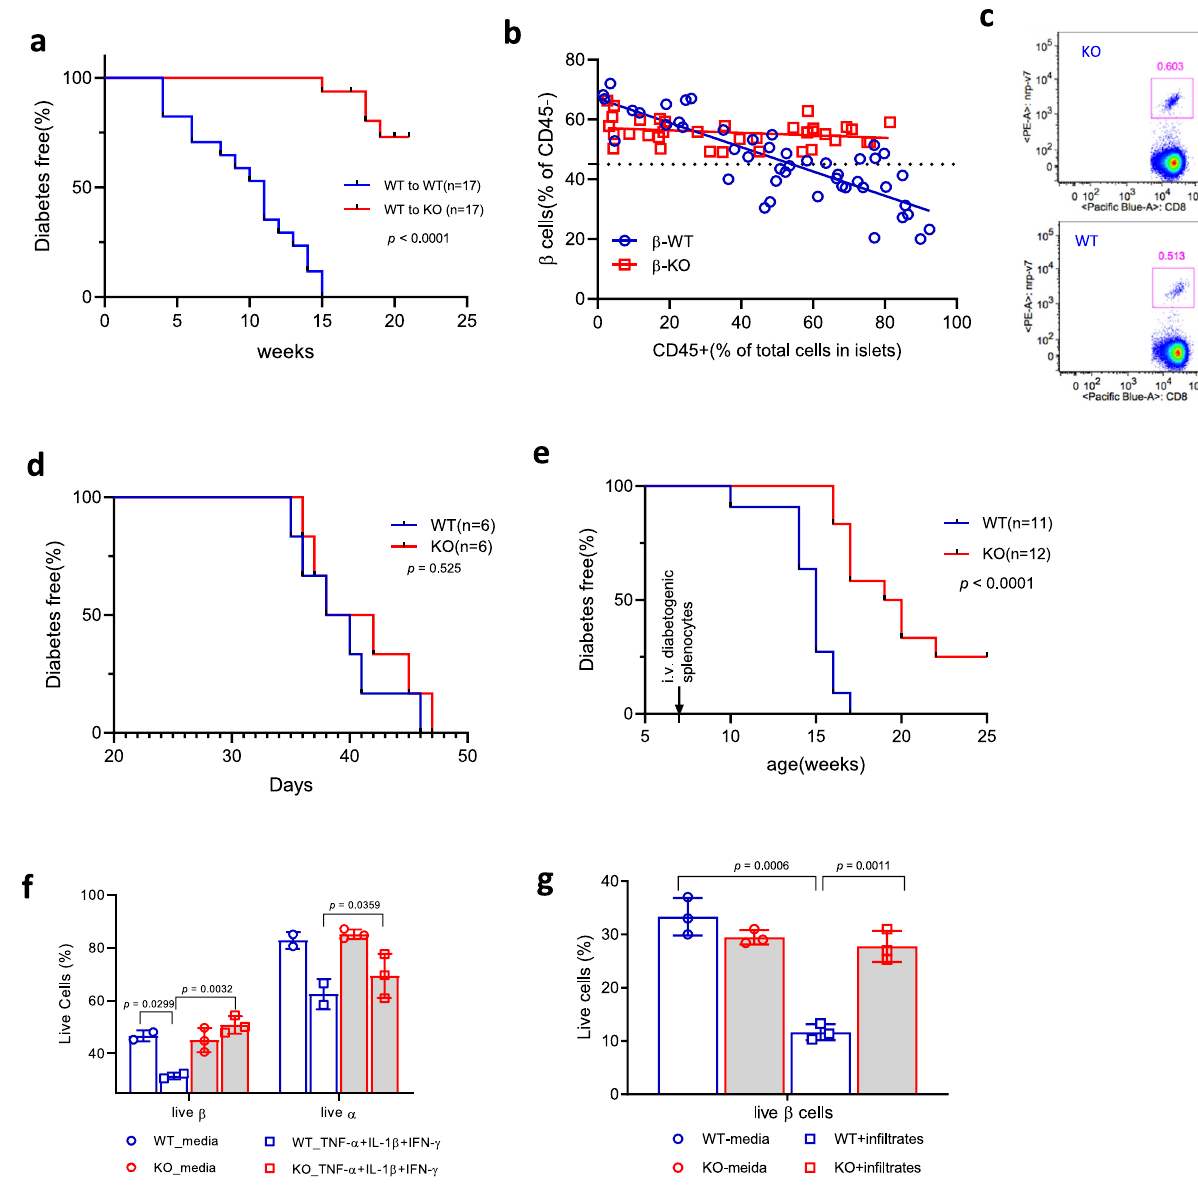
Fig. 3 β cells lacking Tet2 are protected from immune killing in vivo and in vitro. a Diabetes incidence in WT or KO recipients of WT bone marrow. Statistical analysis was performed using Log-rank curve comparison. n = 17 for each group. b Relationship between cellular in fi ltrates and loss of β cells in WT and Tet2-KO recipients of WT bone marrow. The frequency of the intra-islet CD45 + cells and β cells (insulin + ) analysed by FACS. Simple linear regression was used together with a two-side correlation test for statistical analysis. For WT recipients, Pearson r = − 0.82, p < 0.0001; for Tet2-KO recipients, p = ns. Each circle/square represents one mouse (WT, n = 47; KO, n = 36). c Frequency of IGRP-reactive CD8 + T cells in the spleen analysed by FACS. Fourteen weeks after transplant, splenocytes from KO or WT BMT recipients were stained with NRPV7 tetramer to identify IGRP-reactive CD8 + T cells. A single pair, representative of three experiments are shown. d Transfer of diabetes into NOD/ scid mice with 10 7 splenocytes from either nondiabetic KO or hyperglycemic WT BMT recipients 12 weeks post-BMT. Data were from two experiments, each with pooled splenocytes from two KO and two WT BMT recipients. Statistical analysis was performed using Log-rank curve comparison. e Diabetes incidence in islet transplant recipients from either WT or Tet2-KO NOD. About 250 – 300 pooled islets from 5 – 6-week-old WT or KO NOD mice were transplanted under the kidney capsule of 6- week-old WT NOD followed by transfer of 10 7 diabetogenic splenocytes. The median survival time in WT is 15 vs 19.5 weeks in KO recipients. Statistical analysis was performed using Log-rank curve comparison (WT, n = 11; KO, n = 12). f Islet β cell survival during culture with cytokines. Single islet cells from WT or Tet2-KO B6 mice were cultured with the indicated cytokines for 12 h and the live cell percentage was determined in β as well as α cells (identi fi ed by insulin and glucagon staining) by FACS. Results are mean ± SD of three experiments, n = 6 each. Statistical analysis was performed using two-way ANOVA with Tukey ’ s multiple comparisons test. g β cell survival during culture with diabetogenic islets in fi ltrates. Sorted β cells from either WT NOD/ scid or Tet2- KO NOD mice were cultured overnight with islets in fi ltrates sorted from the same prediabetic WT NOD at a ratio of 1:5. Results are mean ± SD of three experiments, n = 5 – 6 each. Statistical analysis was performed using one-way ANOVA with Dunnett ’ s multiple comparisons test.